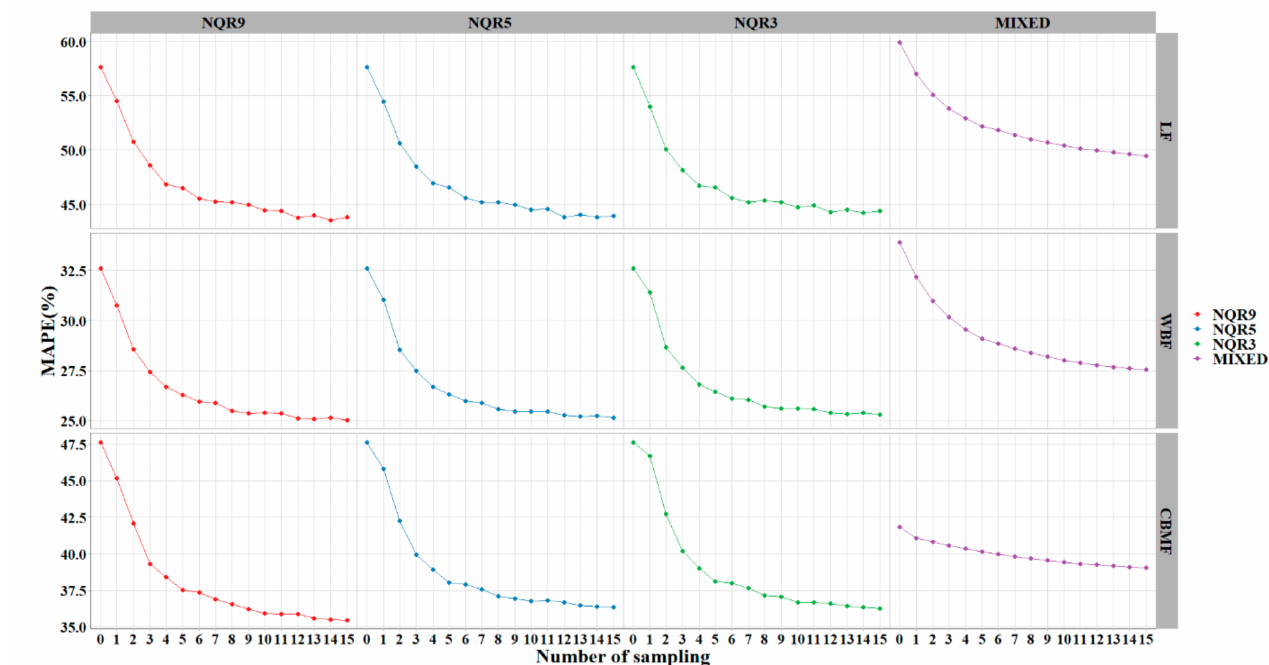
Figure 7. The relationship between MAPE ( % ) and sampling numbers (plots/region) across the four models and three forest